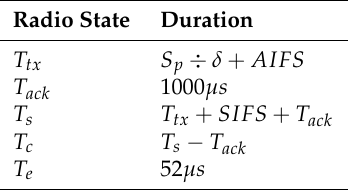
Table 2. The duration of the different radio states based on the IEEE 802.11ah